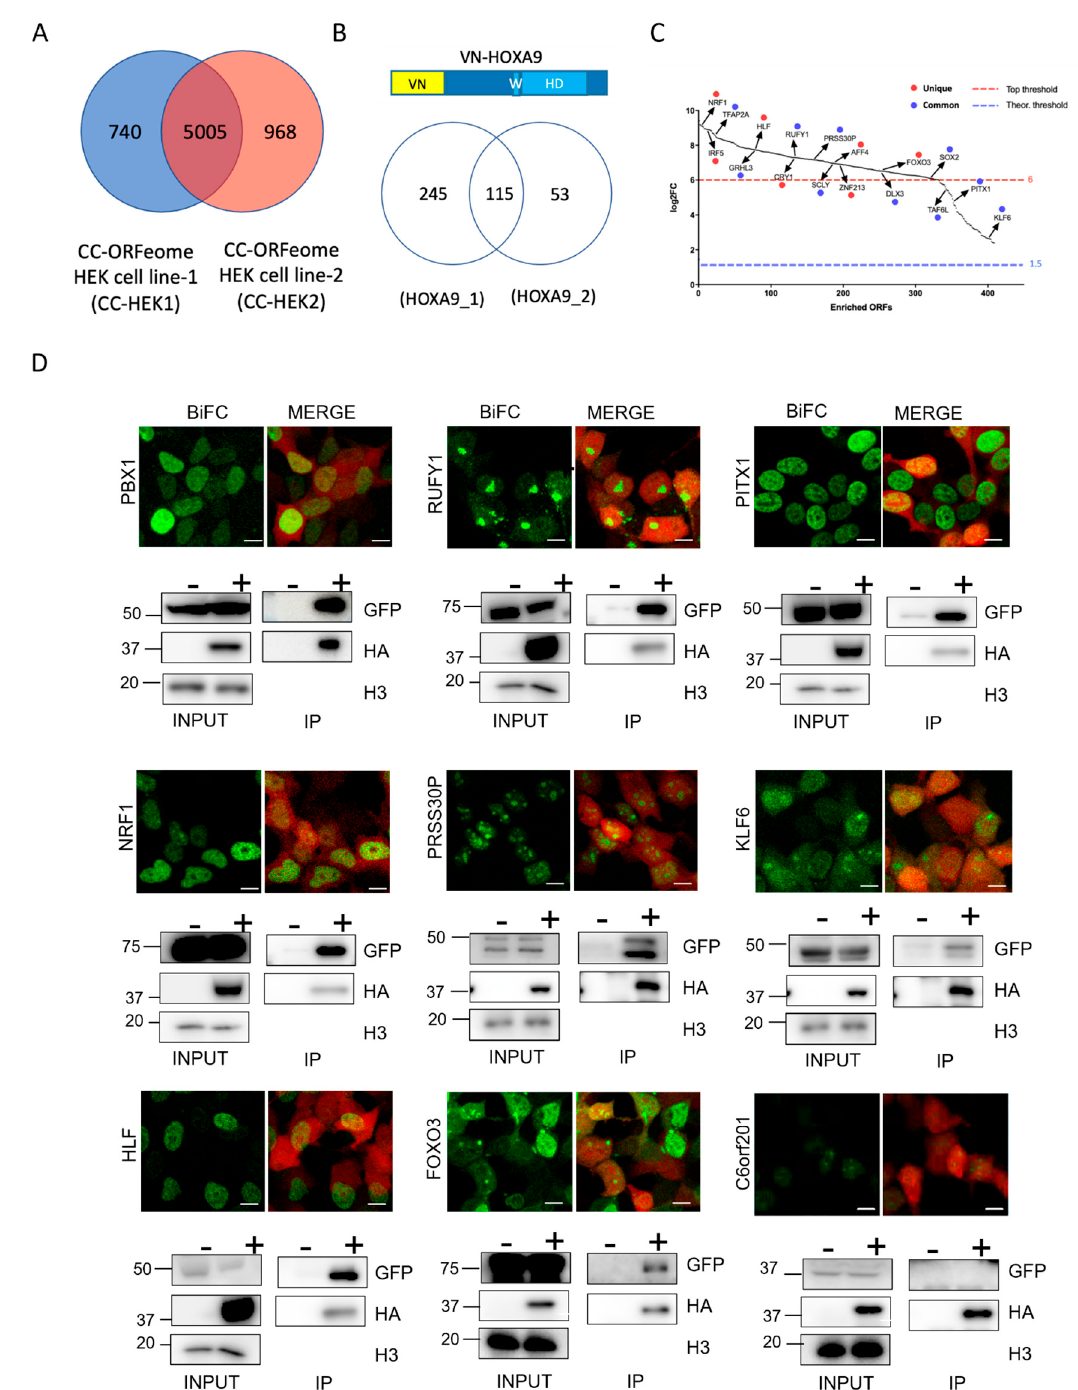
Figure 2. Establishing the Cell-PCA screening strategy with HOXA9. ( A ) Venn diagram depicting the number of integrated ORFs in the CC-HEK-1 (blue) and CC-HEK-2 (red) cell lines. ( B ) Venn diagram showing the number of HOXA9-positive ORFs in the two CC-HEK cell lines. VN-HOXA9 is schematized above the Venn diagram (with the Trp-containing motif—W—and the homeodomain—HD). ( C ) Plot of the 413 selected HOXA9-interacting candidates, ranked from the most to the least enriched in the Cell-PCA assay. Among them, 17 CC-ORFs were randomly picked for individual validation with BiFC using two criteria: the 7 red dots were unique to one CC-HEK cell line with a log2-fold change (FC) superior to 6; the 10 blue dots were common and were revealed in the two CC ‐ HEK cell lines with a log2FC that was superior to the background (1,5). See also Materials and Methods. ( D ) Illustrative confocal pictures of BiFC and co ‐ immunoprecipitation (Co ‐ IP) in HEK293T cells of HOXA9 and the selected candidates as indicated. All pictures are illustrative of